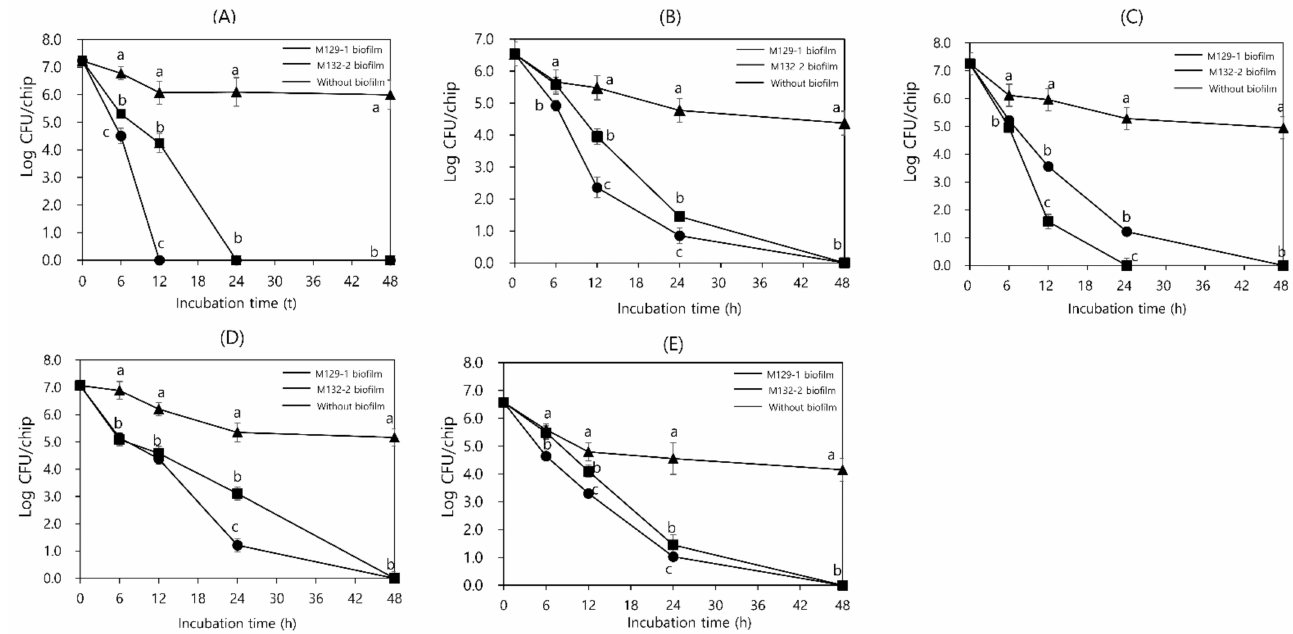
Figure 3. Changes in populations of five pathogens, ( A ) Escherichia coli O157:H7, ( B ) Staphylococcus aureus , ( C ) Listeria monocytogenes , ( D ) Bacillus cereus , ( E ) Salmonella enterica , with or without biofilms of Lactobacillus sakei M129-1 or Pediococcus pentosaceus M132-2, when incubated at 25 ◦ C and 43% (RH) for up to 48 h. Values represent the average of samples from each of the three experiments. Error bars represent standard deviations. Different letters mean a significant difference ( p < 0.05) between samples, following the Ducan’s multiple